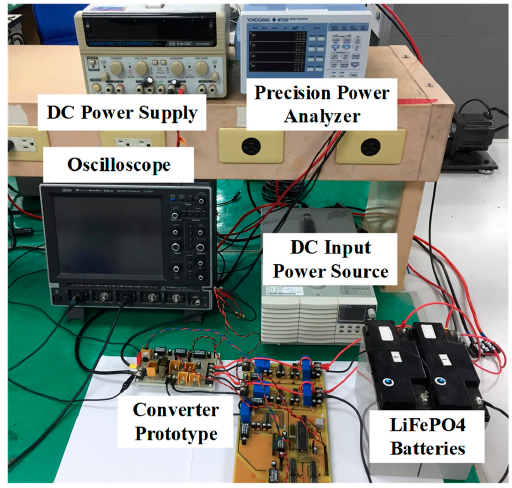
Figure 13. The test setup of the proposed converter.